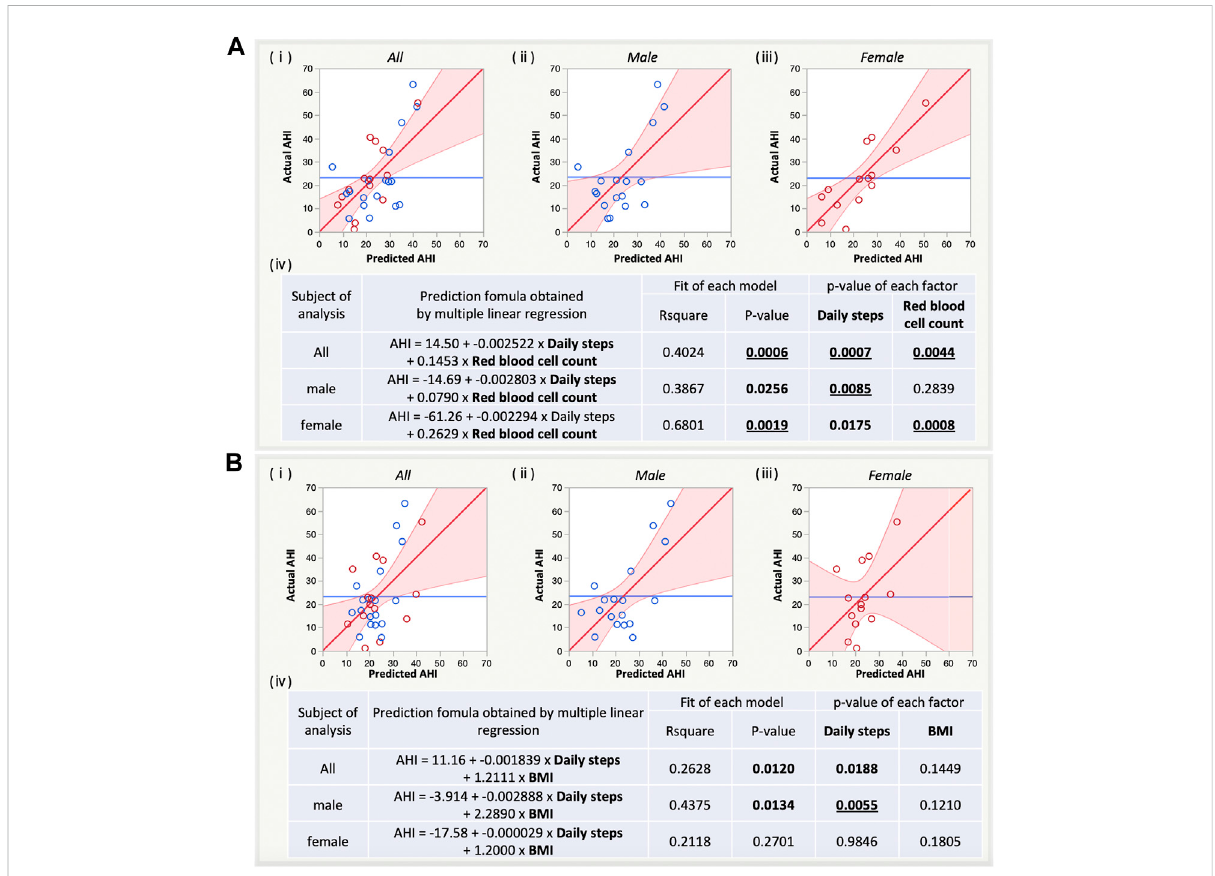
FIGURE 4 Sex-speci fi c estimation of AHI by multiple linear regression (MLR) with the re fi ned pairs of AHI-related factors with [ (A) , a, set A8] and without blood factors [ (B) , a, set B4]. (i) Prediction plot for both sexes, males, and females. (ii) Summary table for sex-speci fi c estimation of AHI by MLR with the re fi ned pairs. AHI, apnoea-hypopnoea index; BMI, body mass